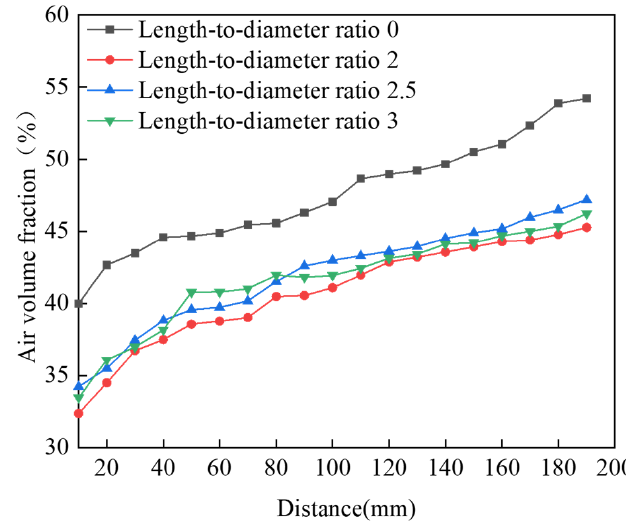
Figure 15. Effect of length-to-diameter on air volume fraction.